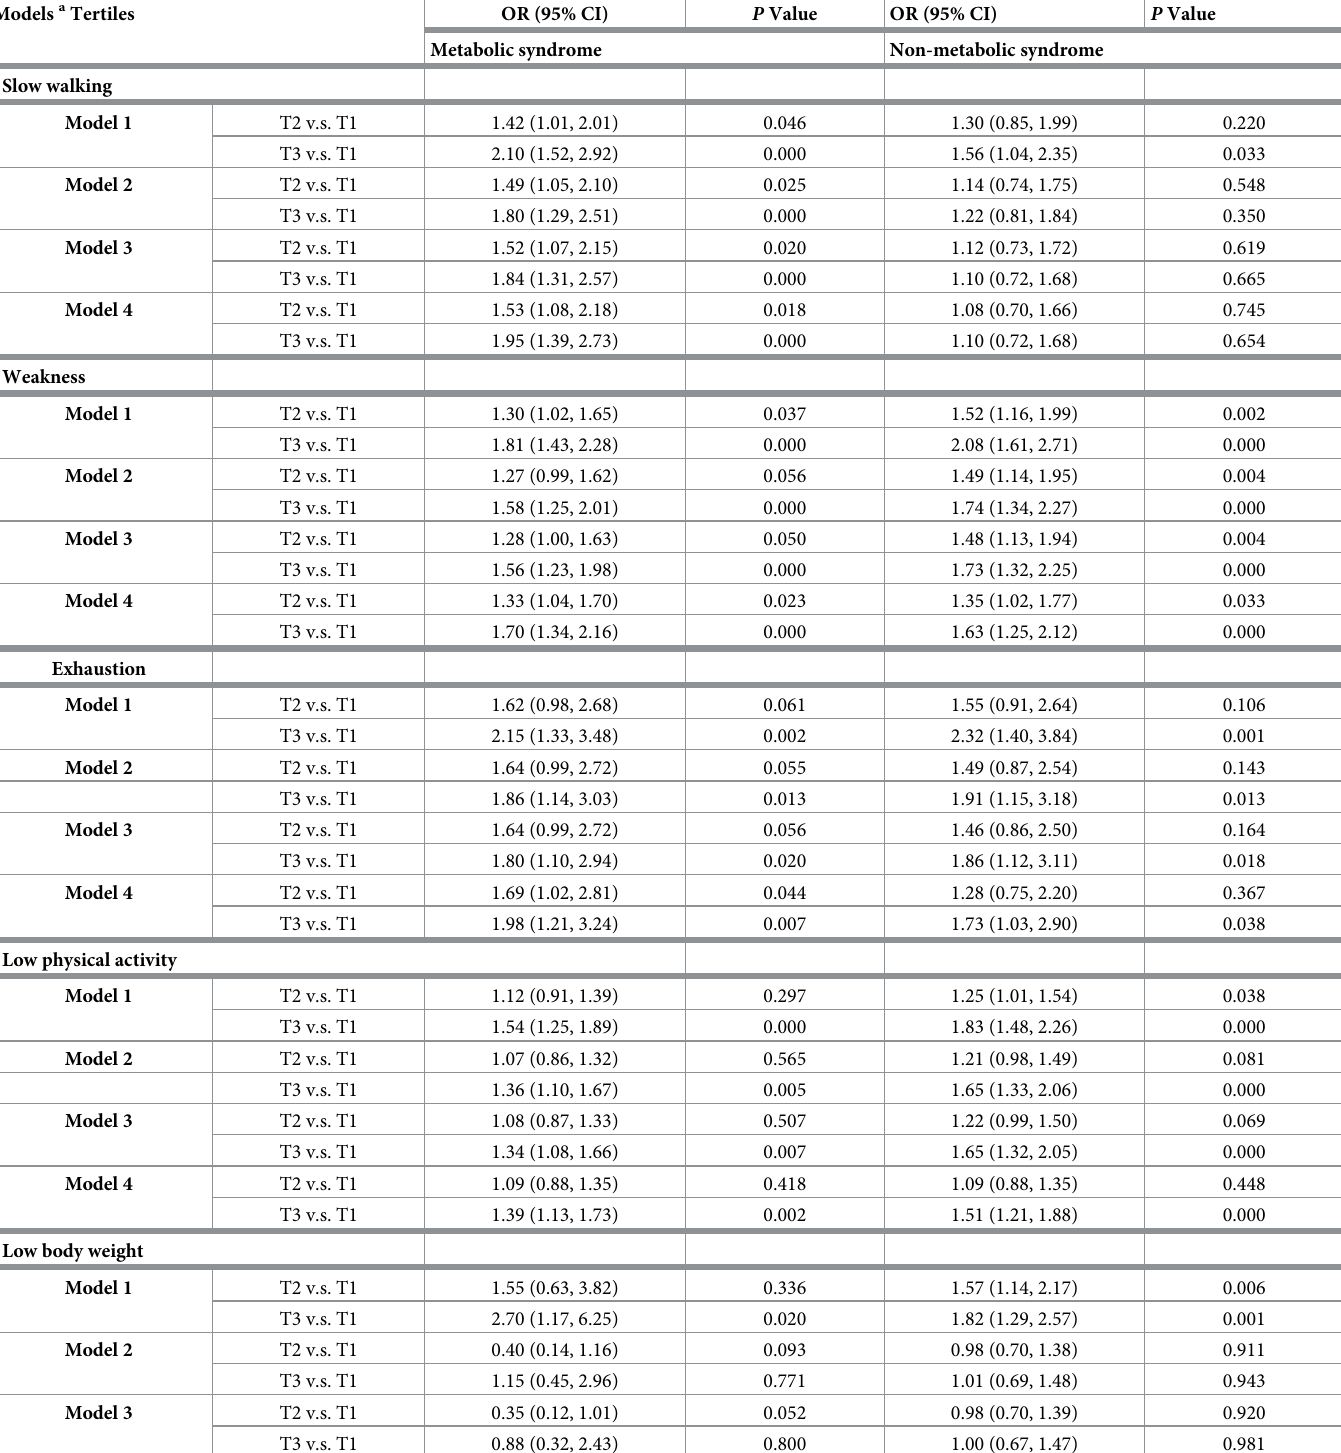
Table 3. Association between frail components and serum LDH level in study participants with MetS and non-MetS. Models a